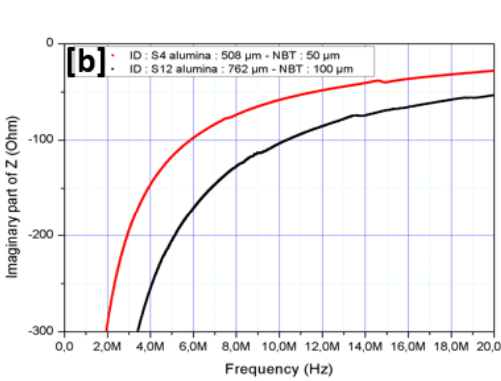
Figure 7 : Electrical impedance real part [a] and imaginary part [b] of S4 and S12